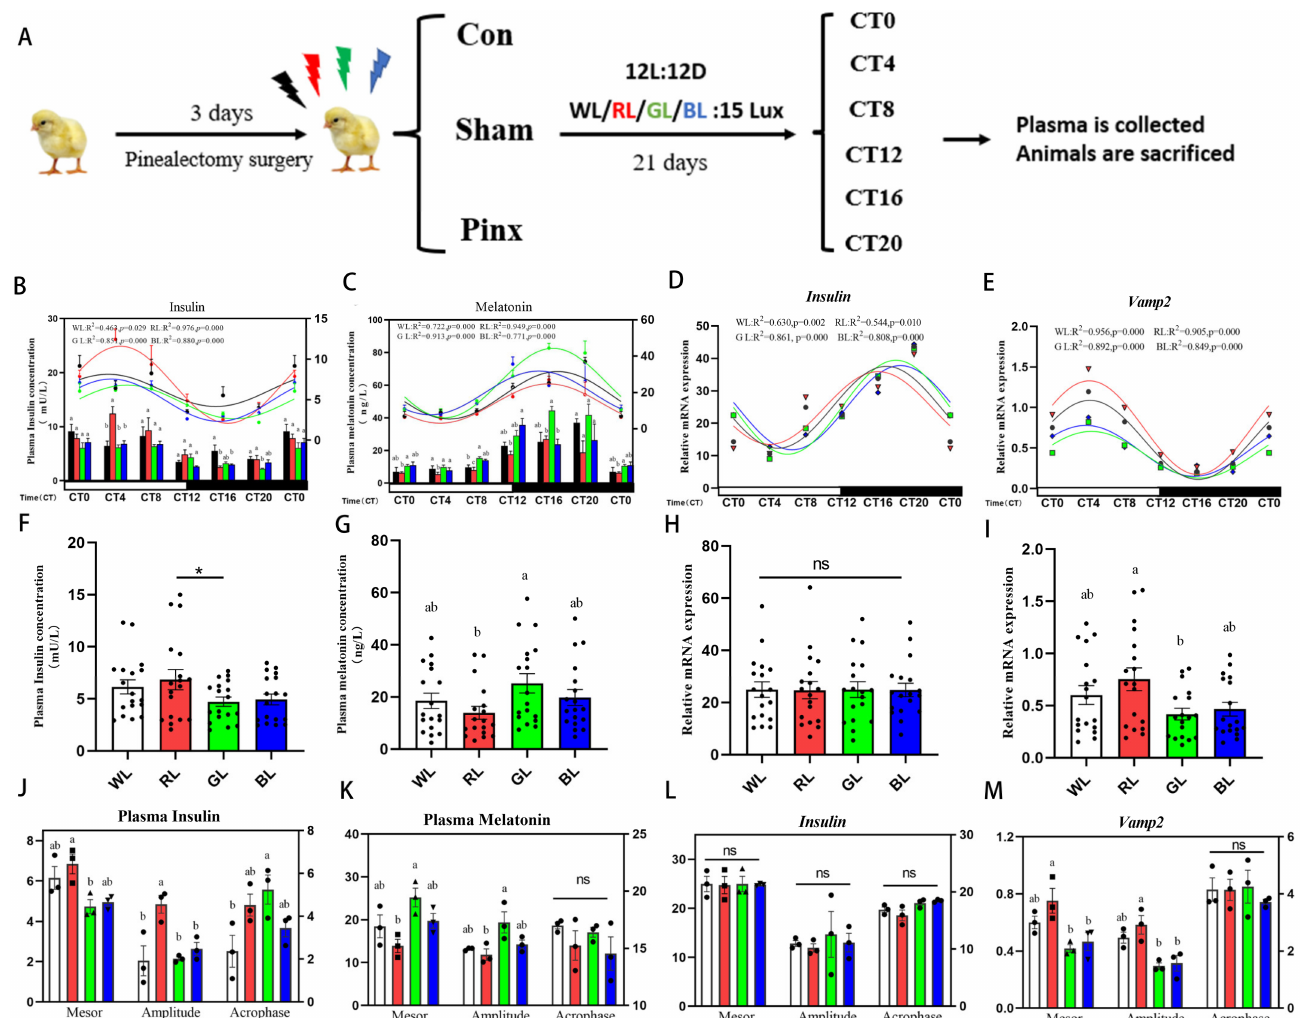
Figure 1. Circadian rhythms of plasma insulin, melatonin and pancreatic insulin-related gene in the chicks under monochromatic light. ( A ): Schematic diagram of animal experiments. Temporal changes of plasma insulin ( B ), plasma melatonin ( C ), pancreatic cInsulin ( D ) and cVamp2 ( E ). The column represents the insulin concentration level (uM/L) (left Y-axis) and the line with symbols represents the 24-h circadian rhythm (right Y-axis). plasma insulin ( F ) and melatonin ( G ) concentration, mRNA expression of cInsulin ( H ) and cVamp2 ( I ), rhythmic parameters of plasma insulin ( J ), melatonin ( K ), cInsulin ( L ) and cVamp2 ( M ) (the mesor and amplitude according to left Y-axis, the acrophase according to right Y-axis). The horizontal white bar on each figure represents the subjective day, and the black bar represents the subjective night. Quantitative analysis of the PCR data is shown as the mean ± SEM. * p < 0.05, ns: no significance. CT, circadian time. CON: intact group; Sham: sham operation group; Pinx: pinealectomy group. The curve indicates the best fit to the points by cosinor analysis. R 2 values represent the degree of fitting, p -values indicate the significance of regression analysis, with significance defined as p < 0.05. Different letters indicate significant differences among the monochromatic light groups, and the light treatments are represented with different colors (black, WL; red, RL; green, GL; blue,